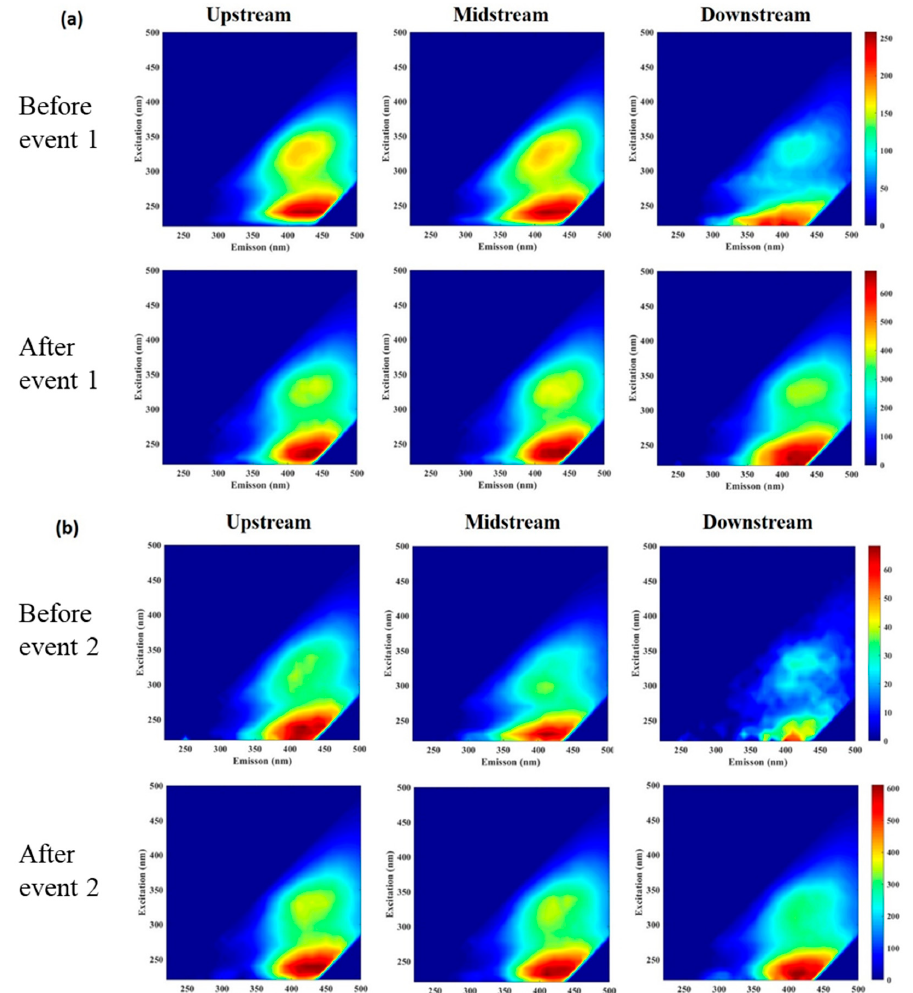
Figure 5. EEMs of samples based on their sampling points: ( a ) EEM results in Event 1; ( b ) EEM results in Event